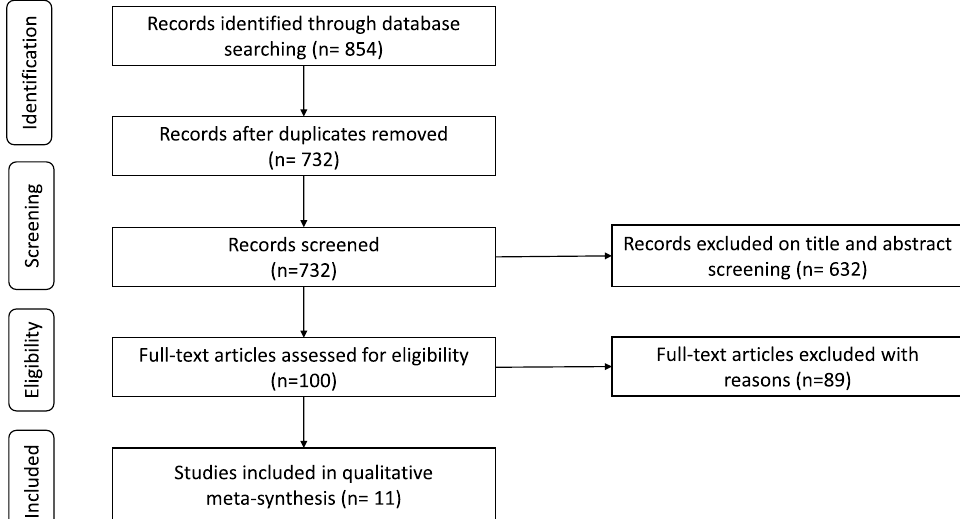
Fig. 1 PRISMA flow chart of the review